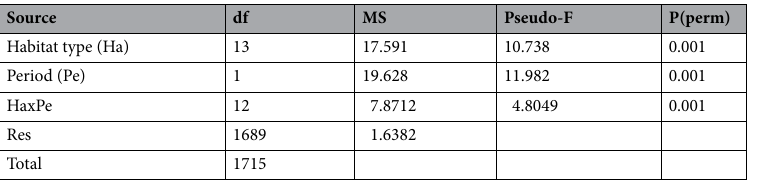
Table 7. PERMANOVA table of results: comparison of multivariate assemblage of juvenile density between habitats and periods. Table gives degrees of freedom (df), Mean Squares (MS), calculated pseudo-F, and P-values (P). P-values were obtained by 999 permutations of residuals under a reduced model (perm) or through Monte Carlo test (MC, see “Material and methods”).